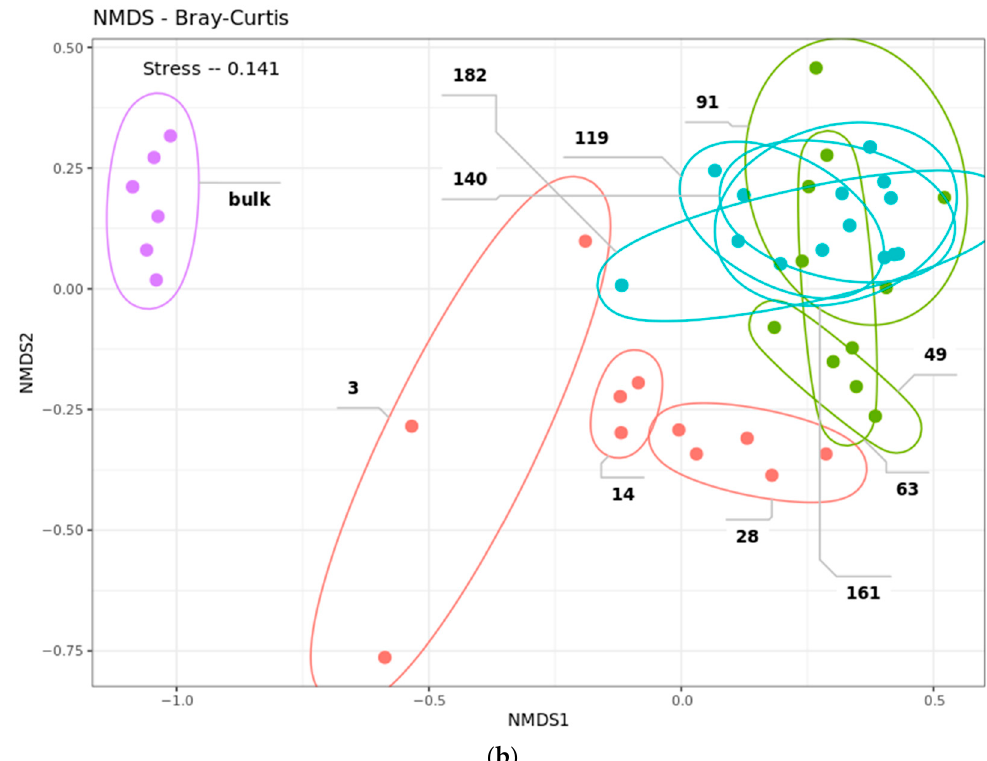
Figure 3. NMDS plot of the beta-diversity of the microbial straw decomposing community from ten sampling points accessed with Bray–Curtis, based on ( a ) 16S rRNA gene and ( b ) ITS2 amplicon sequencing data. Replicates of each sampling day are surrounded by ellipses. The number of the ellipse indicates the day from the beginning of the experiment when the sample was taken. The color represents phase of the experiment: red — early phase, green — middle phase, blue — late phase, purple — control chernozem soil (bulk).